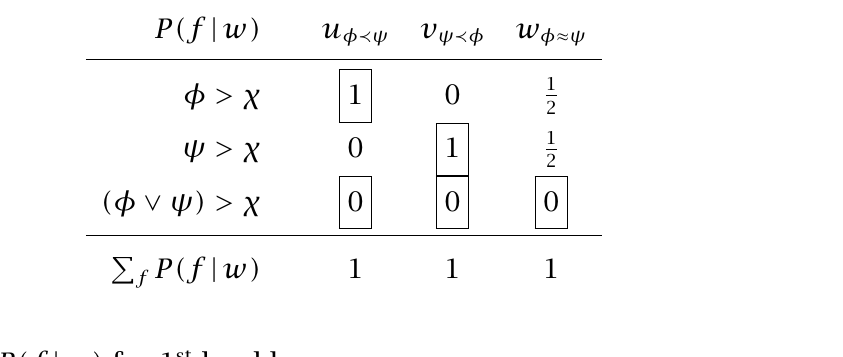
Figure 3 P(f | w) for 1 st -level hearer